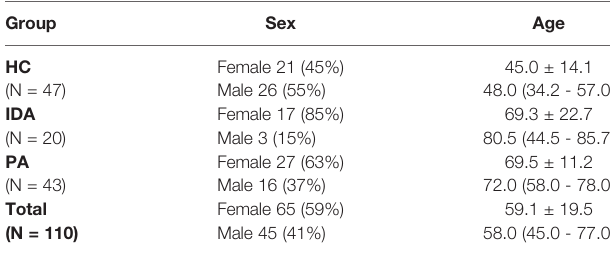
TABLE 1 | Sex (N, %) and age (mean ± SD; median and Q1-Q3) of study